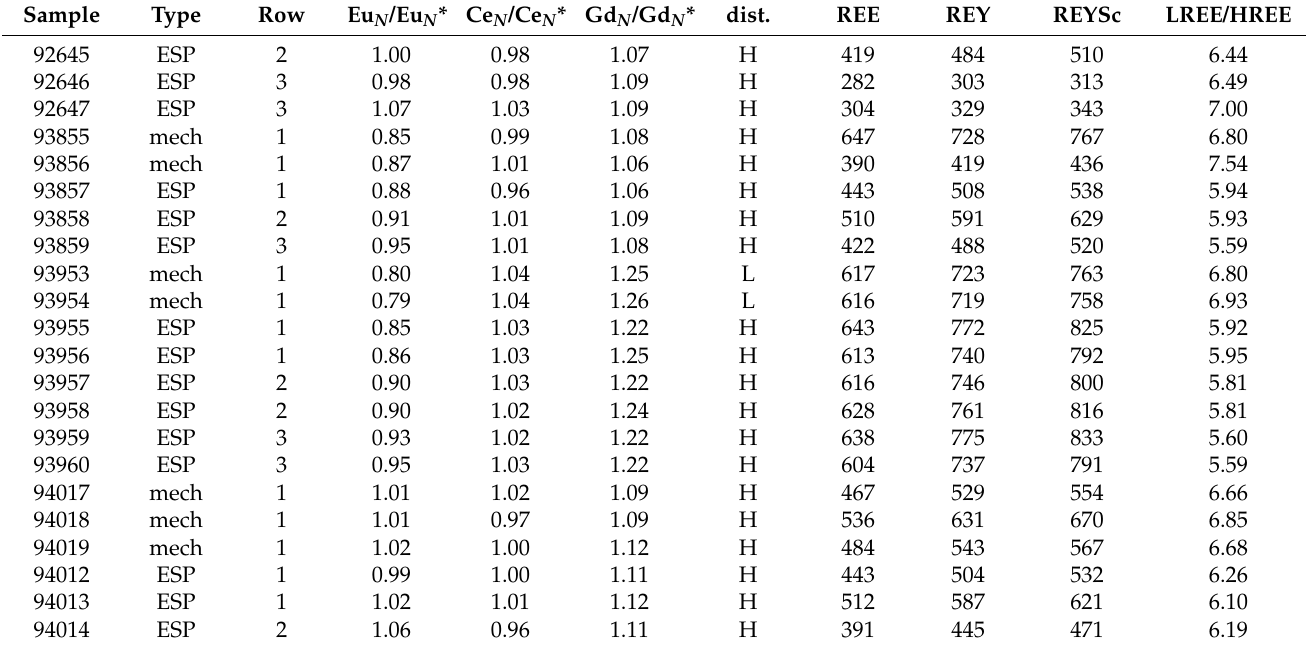
Table 6. Rare earth-related